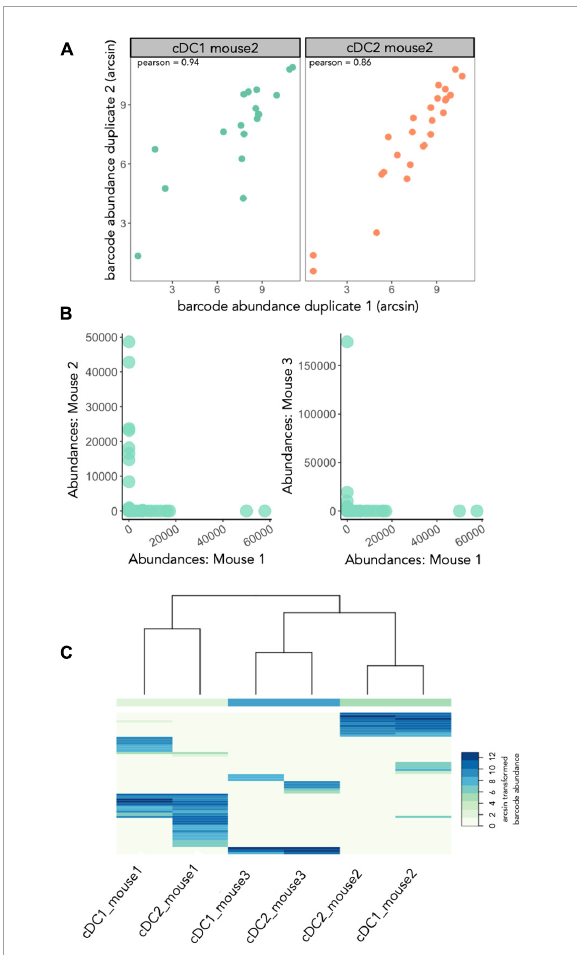
FIGURE4 Analyzing the impact of sequencing errors and repeat use barcodes (A) comparing technical replicates for cDC1 and cDC2 samples of mouse 2 from case study 1 to control for sequencing errors On these plots each dot represents a single barcode and the Spearmans correlation coefficient is given at the top of each plot (0.79 for the cDC1 sample and 0.93 for the cDC2 sample). This is a representative plot showing data from 1 mouse, figures for the other mice can be found in Supplementary Figure 1 . (B) Assessing repeat usage of barcodes by comparing barcode abundances across distinct individual mice from case study 1. (C) Same as panel (B) but using a heatmap to compare all the mice together. Renormalized data is arcsin transformed, clustering based on Euclidian distance and complete linkage. The frequency of repeat use barcodes is 3.4% in this dataset. After sample QC a total of 60 barcodes were recovered for lung cDCs across three mice (m1 = 32 barcodes, m2 = 17 barcodes, m3 = 11